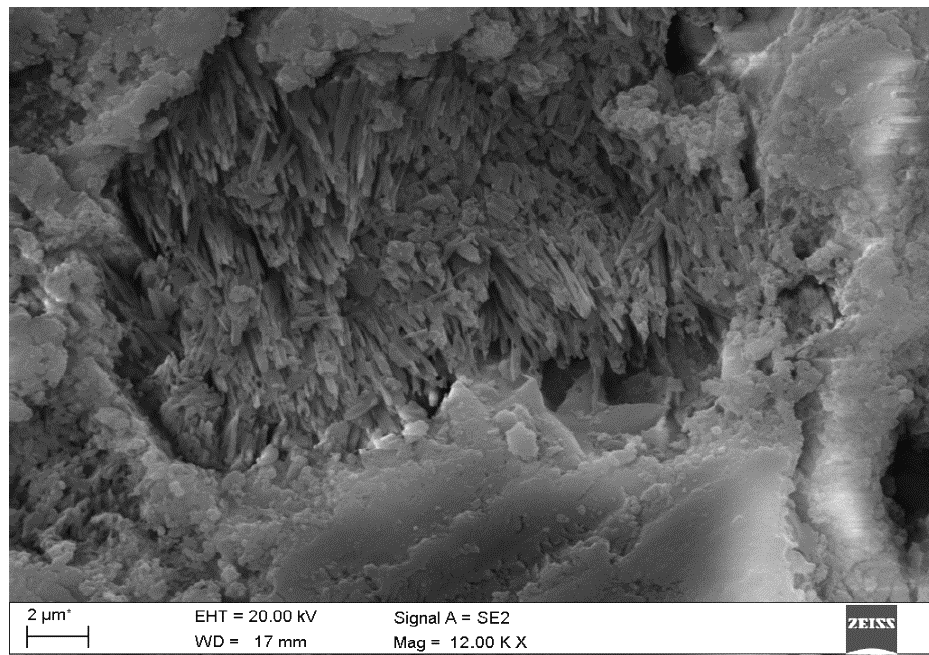
Figure 10. Filling the pore with gypsum at a depth of 1.0 mm in sample B-25.